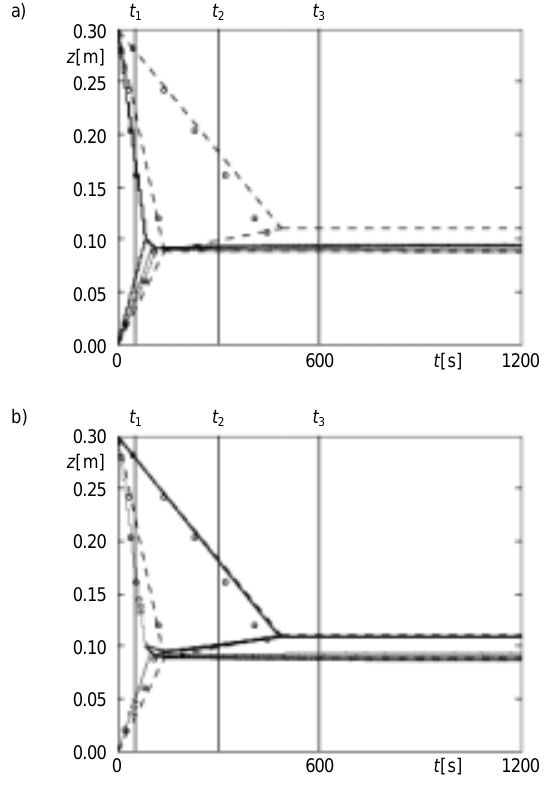
Fig. 10 Settling of a bidisperse suspension of heavy particles of two different sizes: iso-concentration lines (a) of the larger particles and (b) of the smaller particles, corre- sponding to the values of f i 0.02, 0.04, 0.06, 0.08, 0.1, 0.15, 0.25, 0.3, 0.4, 0.5 and 0.6. The circles and the dashed lines correspond to experimental measurements of interface locations and shock lines, respectively, obtained by Schneider et al. (1985). Concentration pro- files taken at the times t 1 , t 2 and t 3 are given in Figure 11 .